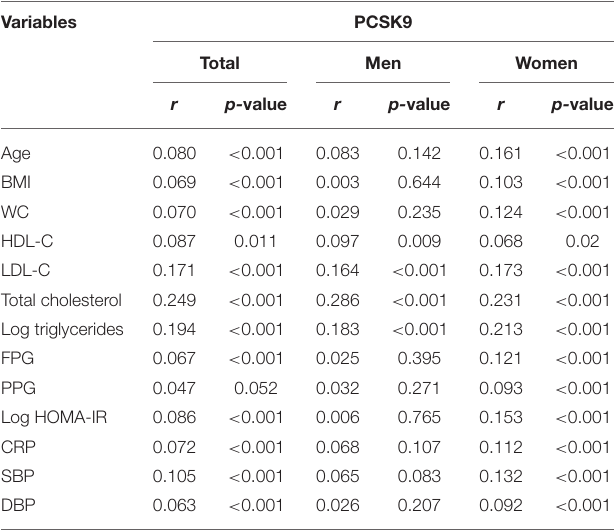
TABLE 2 | Pearson correlation analysis between baseline circulating PCSK9 and clinical characteristics.